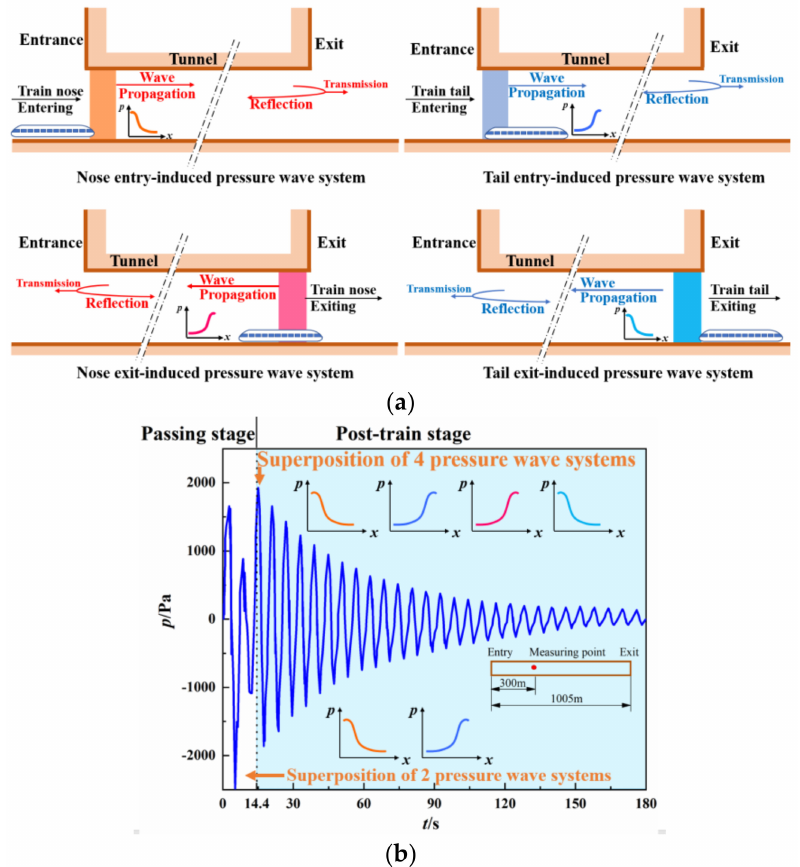
Figure 2. Schematic of pressure fluctuation in two stages: ( a ) Four pressure wave systems induced by a high-speed train entering/exiting from a tunnel; ( b ) Pressure fluctuation of the passing stage and post-train stage. (adapted from Liu et al.